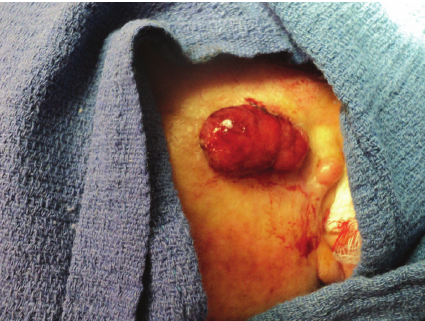
Figure 1: Original patient presentation with preauricular nodule.